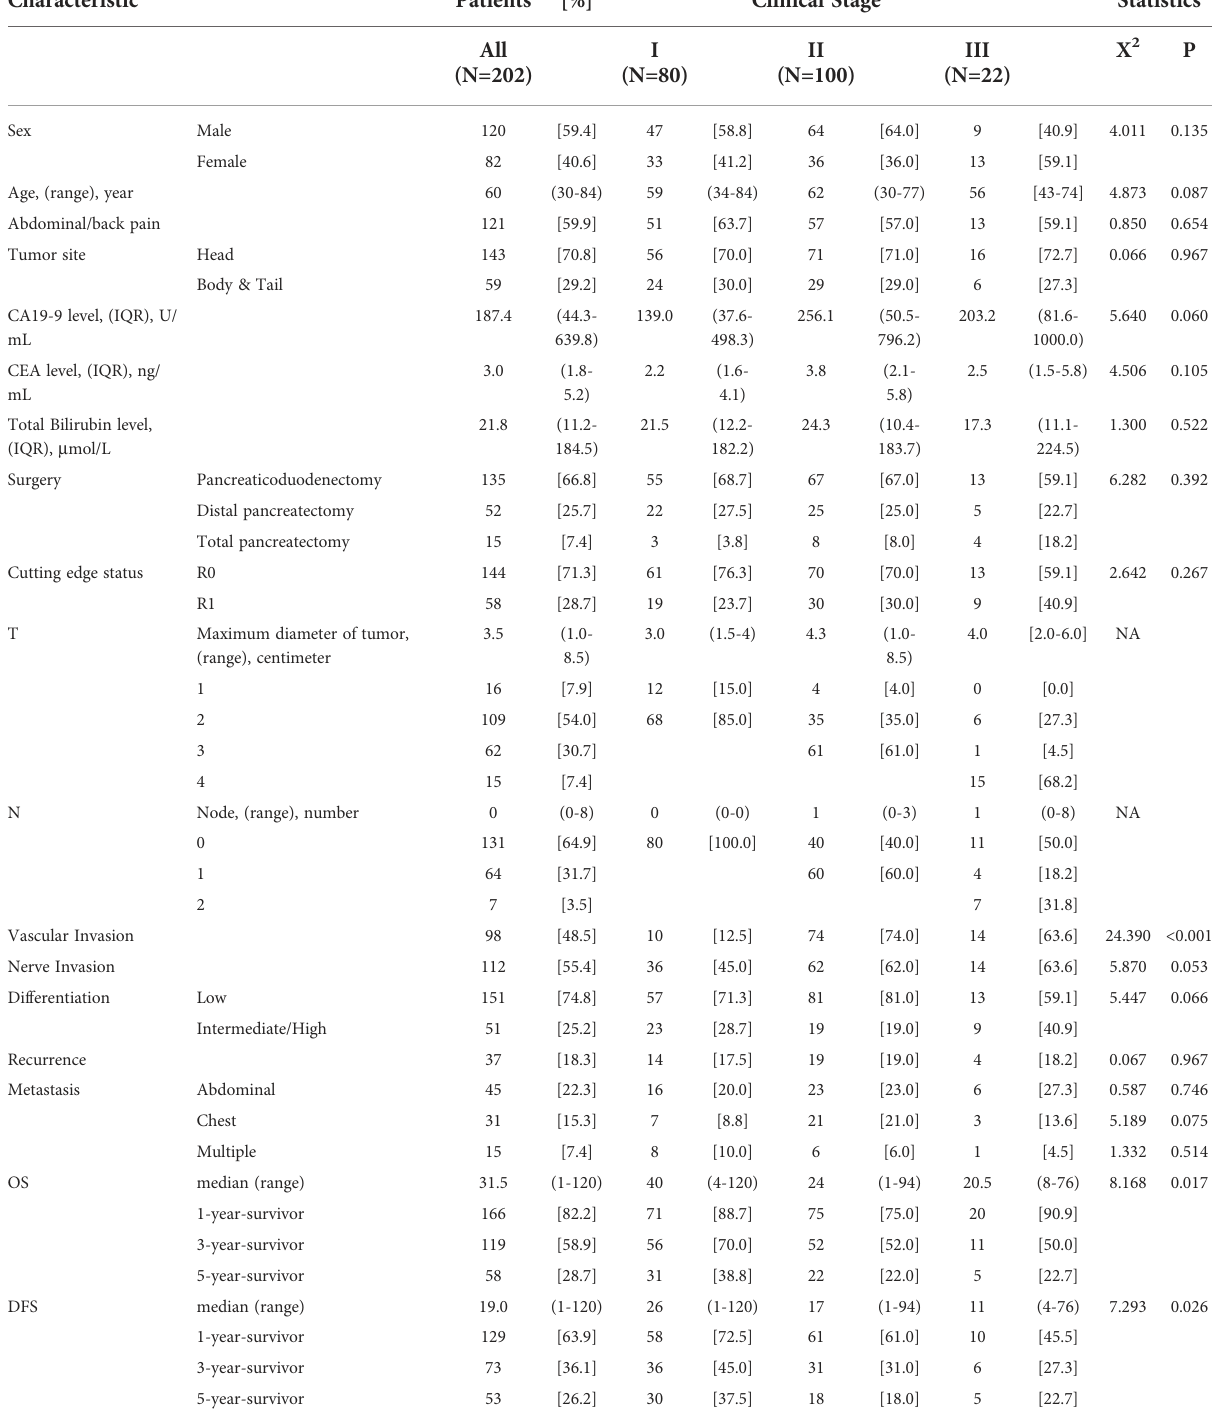
TABLE 1 Patient characteristics and baseline